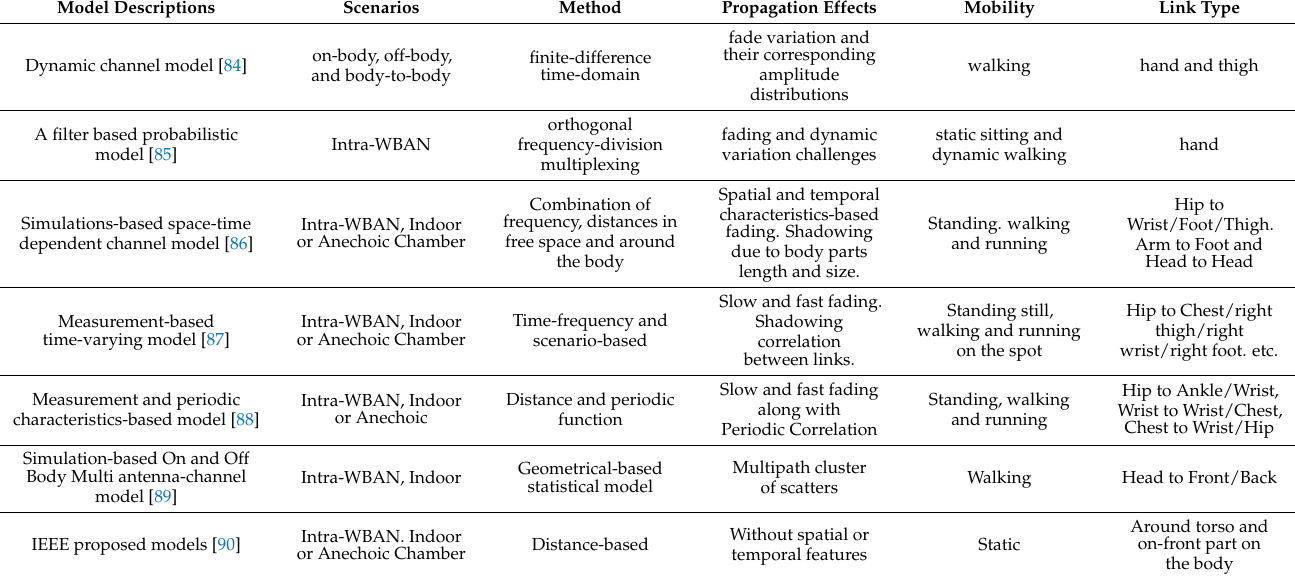
Table 10. The existing WBAN channel